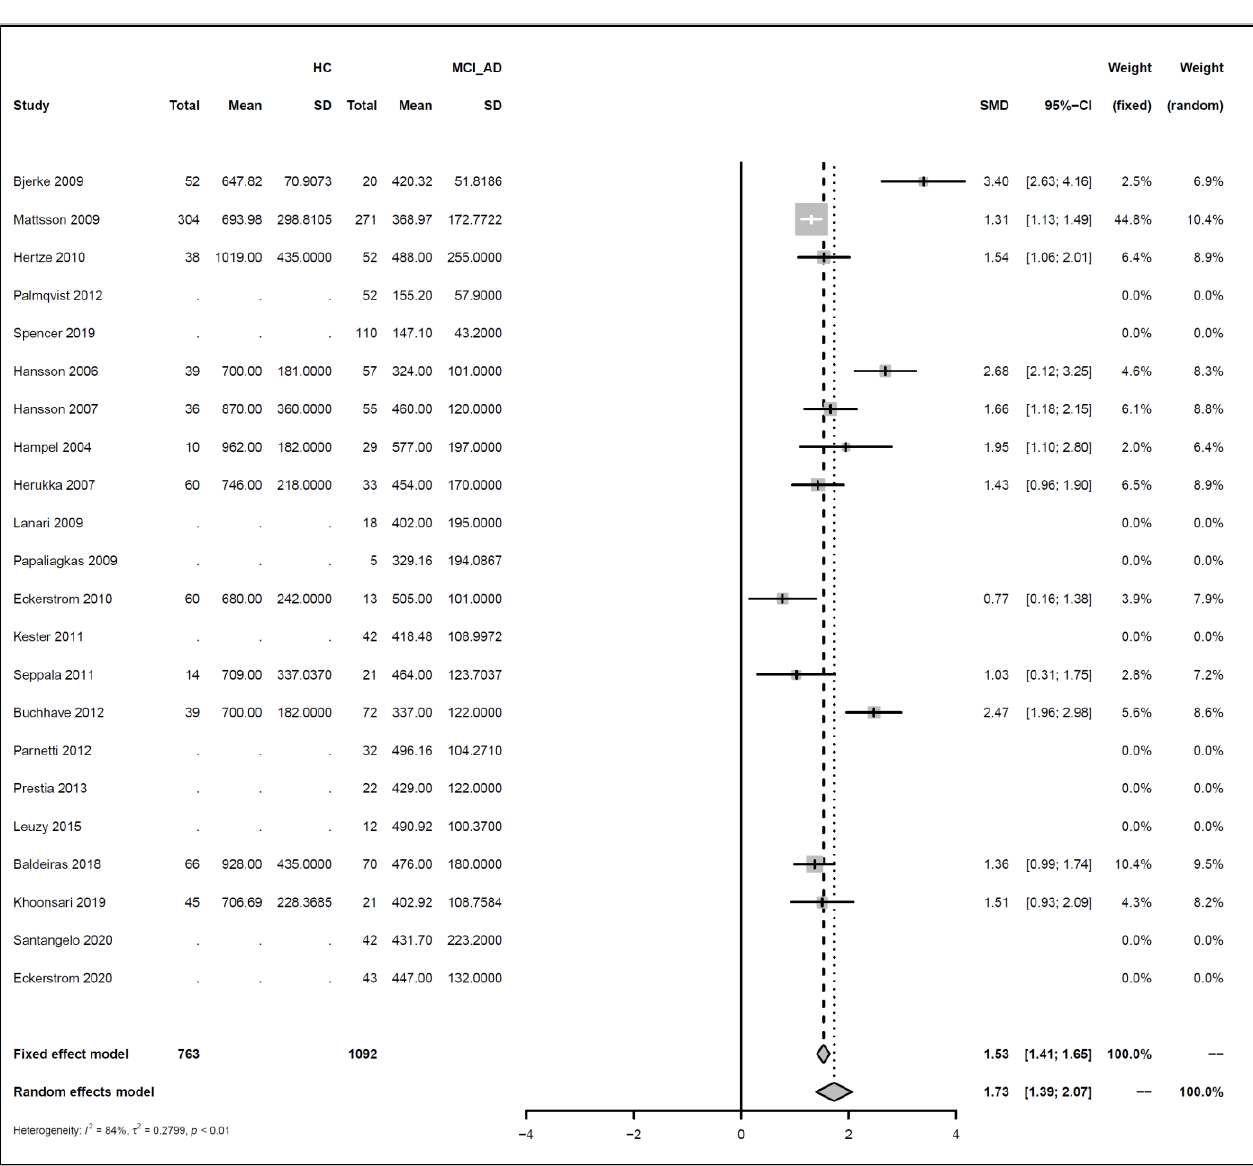
Figure 8. Meta analysis of studies investigating CSF Aβ1 -42 levels for healthy control (HC) versus progressive MCI (MCI_AD), see Appendix A.2.2 [30,32 – 37,44 – 58].